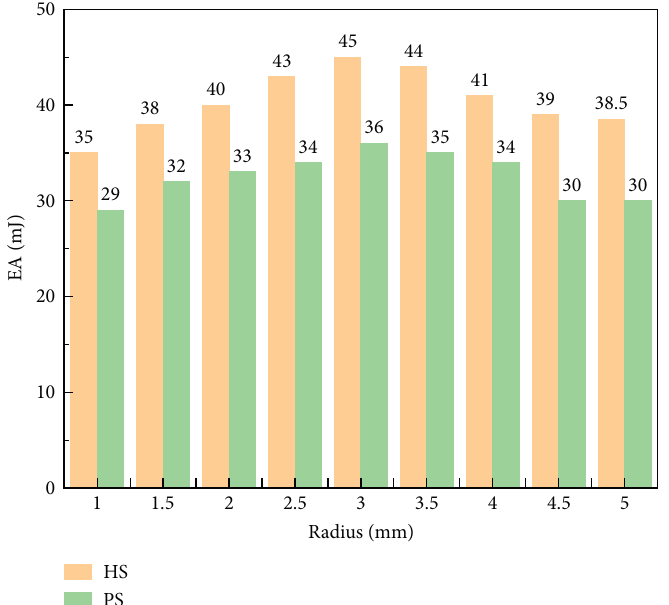
F IGURE 2: Energy absorption analysis results of arc-honeycomb cell and arc negative Poisson cells with different radius of arc.